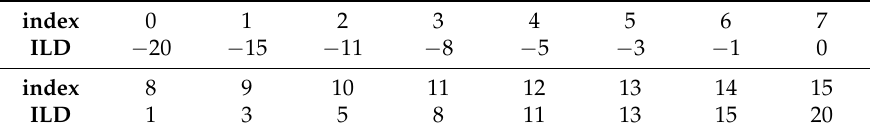
Table 5. Codebook for ILD. (ILD, Interaural Level Difference).